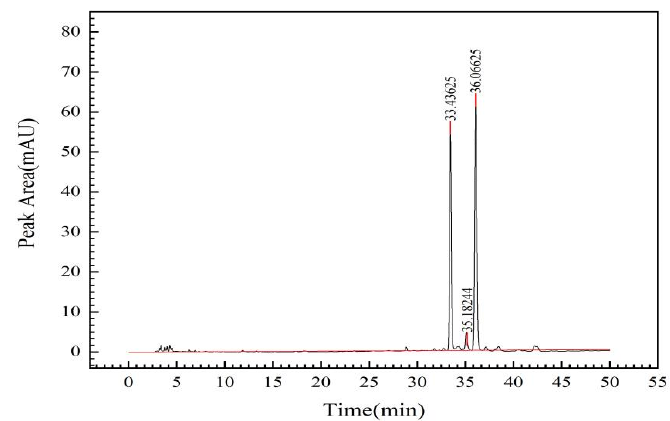
Figure 3. Liquid chromatography of C. oleifera saponins solid sample. Table 3. Repeatability experimental data.